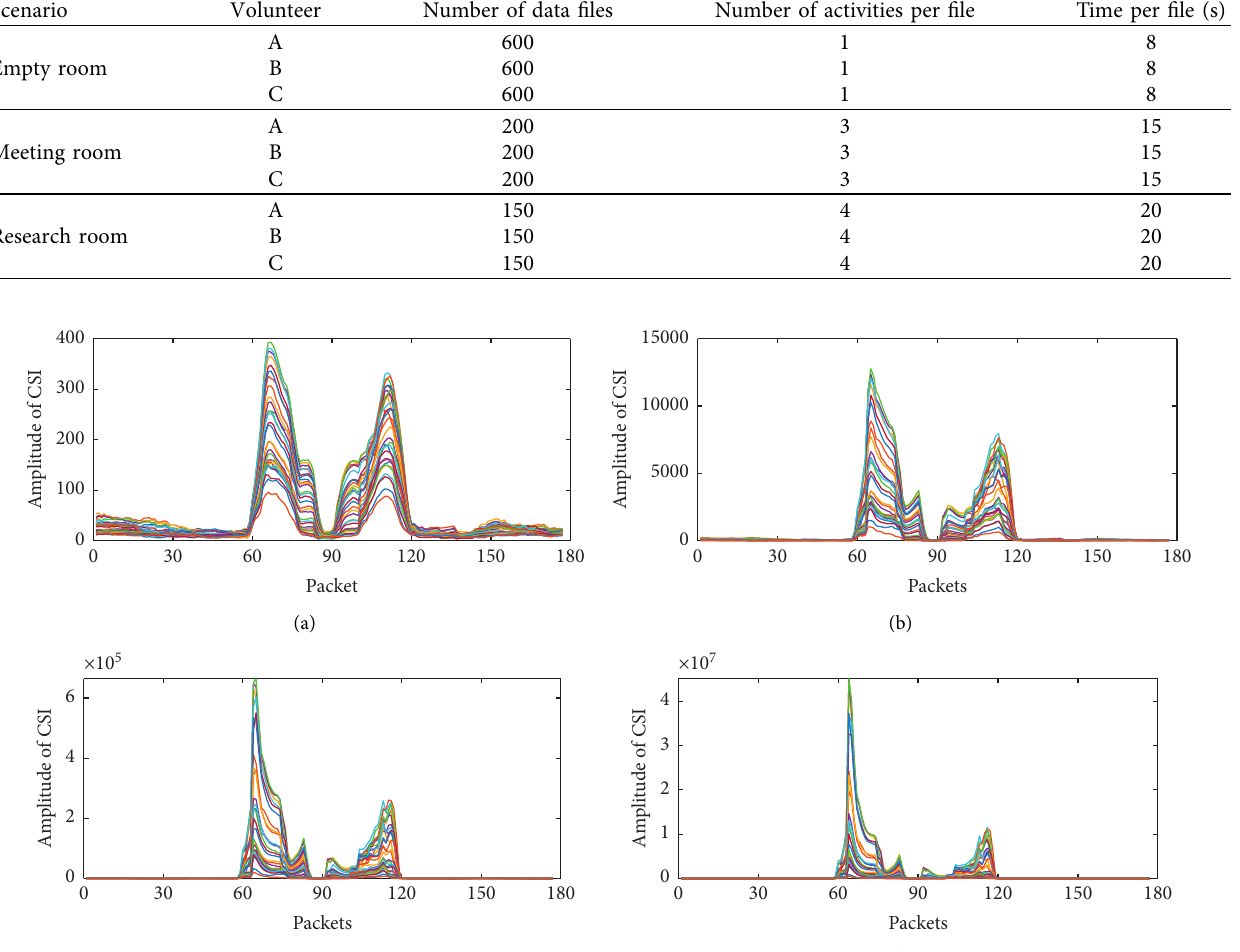
Table 1: The details of datasets in three scenarios.